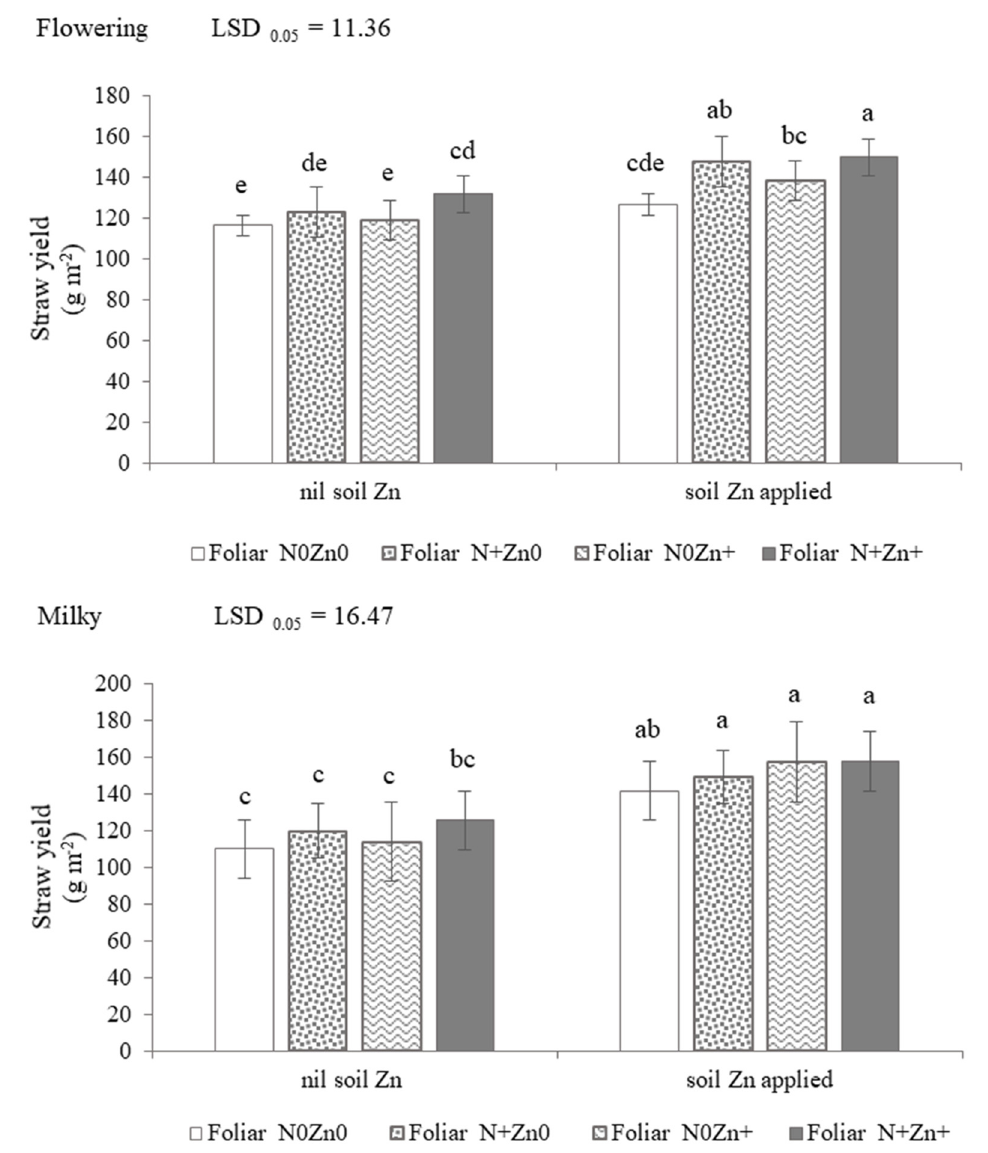
Figure 2. Straw yield of the SPT1 rice variety grown at different foliar N and Zn fertilizer rates under two soil Zn treatments at the flowering and milky stages. Each value is the mean of four independent replications. Different letters above the bars indicate significant differences by LSD (0.05). The error bars indicate the standard deviation of each treatment mean (SD) ( n = 4).